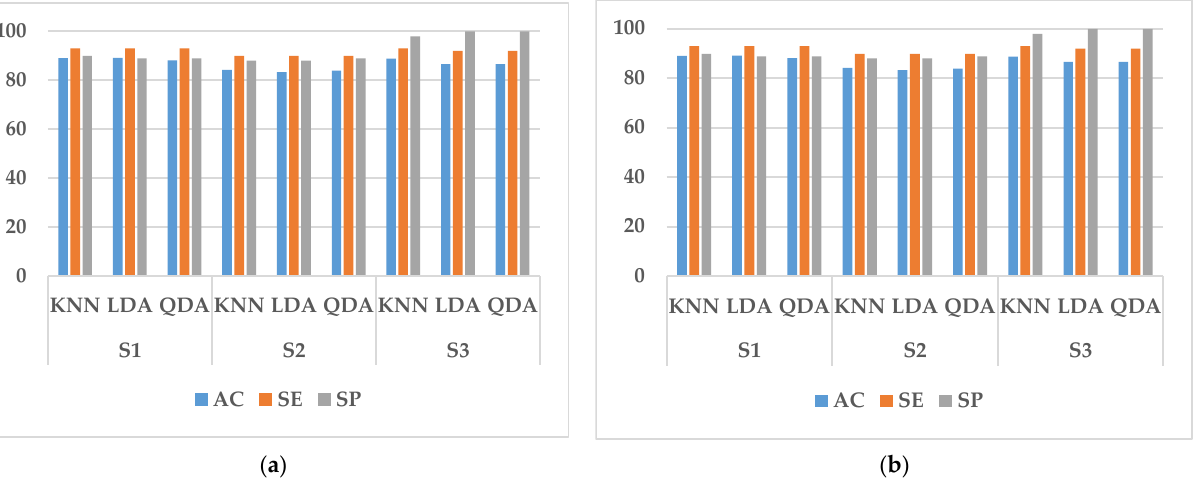
Figure 8. K-fold cross-validation of EMG data. ( a ) Vehicle driving experiment; ( b ) Simulated driving experiment.